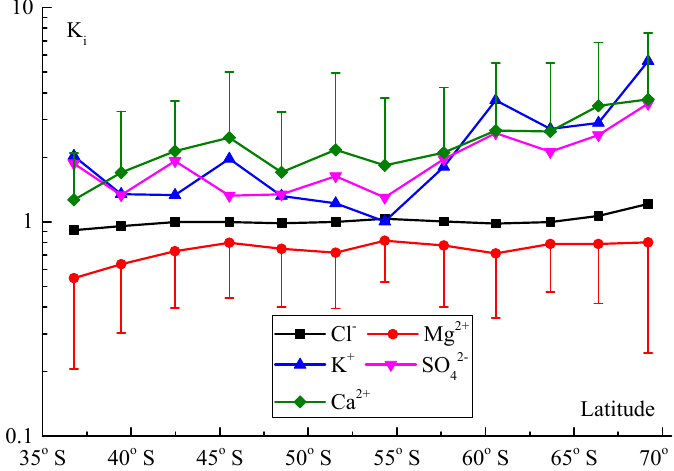
Figure 13. Latitudinal change of the enrichment coefficients of different ions.